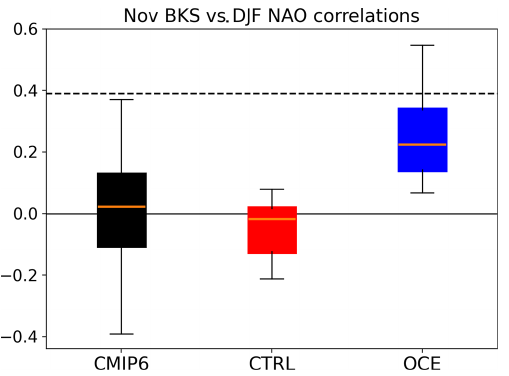
Figure 3. Boxplots of correlations between sea ice anomalies in the November Barents–Kara sea ice and the DJF NAO mean, over the period 1980–2015, for CMIP6 (black), CTRL (red), and OCE (blue). In each case, the box extends from the first to the third quar- tile of the data, with a line at the median. The whiskers extend from the box by 1.5 times the inter-quartile range. The stippled black line marks the correlation attained in ERA5.